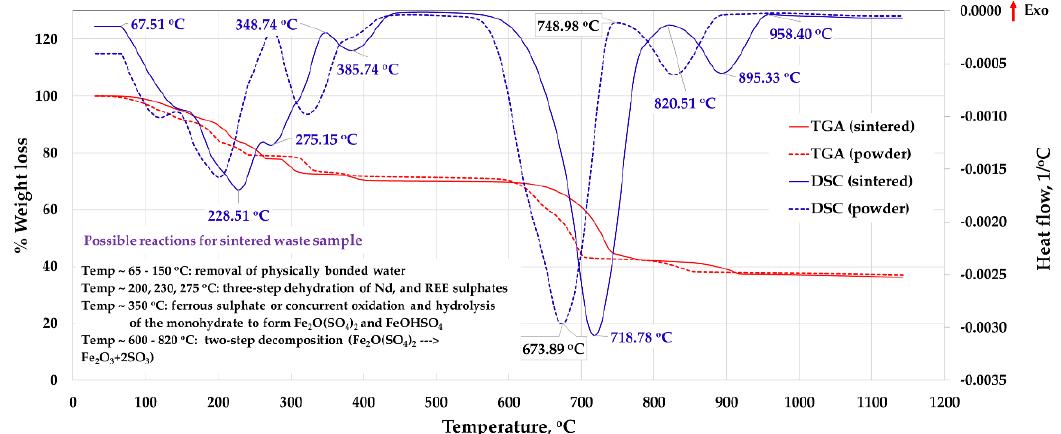
Figure 4. The TG / DSC result of leached products, a comparison between sintered and powder Figure 4. The TG/DSC result of leached products, a comparison between sintered and powder wastes.